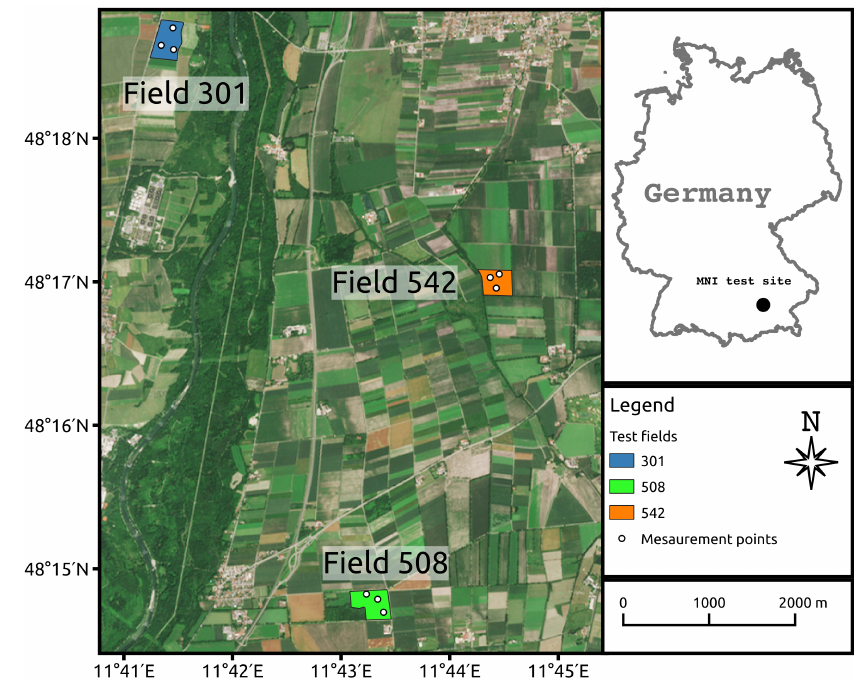
Figure 1. Overview of study area Munich-North-Isar (MNI) located in southern Germany (Bavaria). Three wheat test fields—508 (green), 542 (orange), and 301 (blue)—with three measurement points each of the field campaign in 2017 are highlighted. Reference system: WGS84 (EPSG:4326)